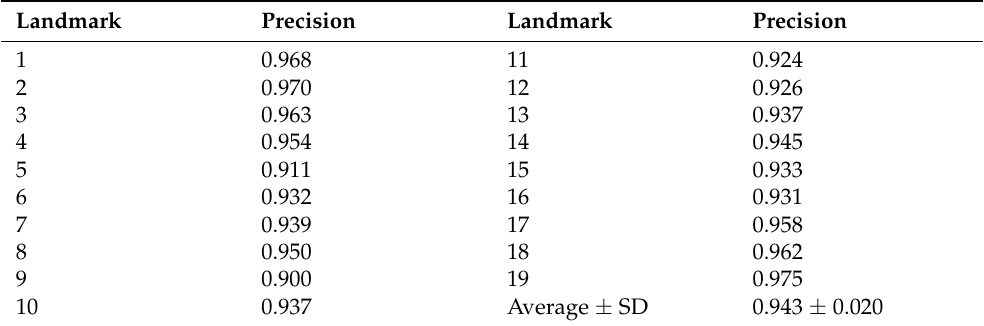
Table 3. Positional precision of the 19 detected landmarks. The landmarks correspond in nomination to the sequence of annotated numbers shown in Figure 1b.